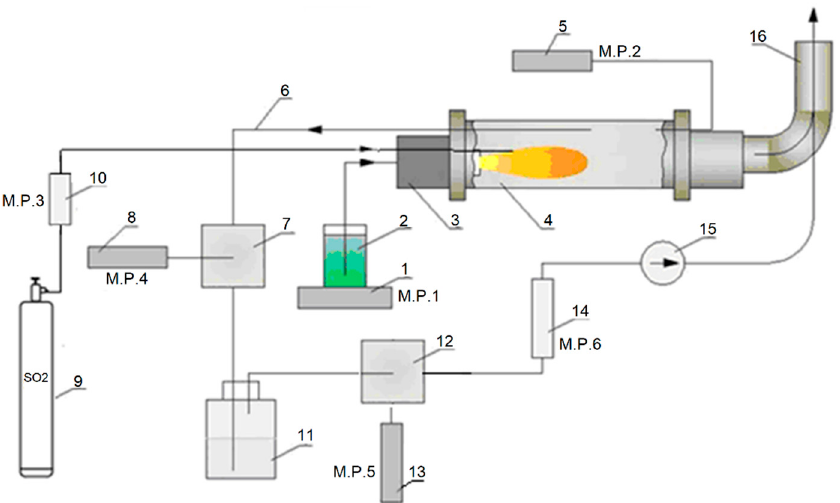
Figure 2. Scheme of a laboratory plant: 1—fuel consumption measuring device (M.P.1),